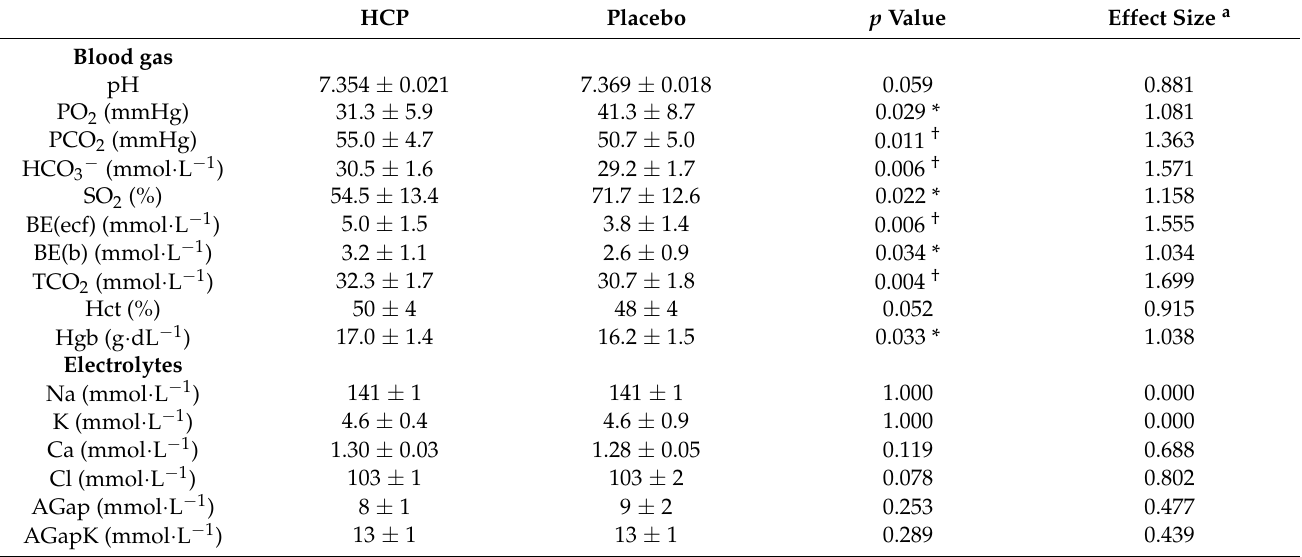
Table 1. Mean values of blood gas, electrolytes, metabolic parameters, TR − NIRS and heart rate profiles at rest between HCP and